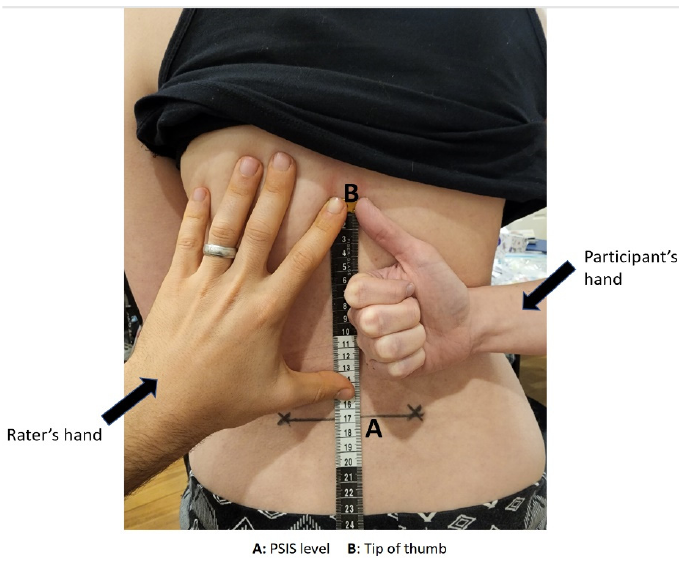
Figure 3. HBB testing position adapted with permission from van den Dolder et al. [29]. 2014, Churchill Livingstone.